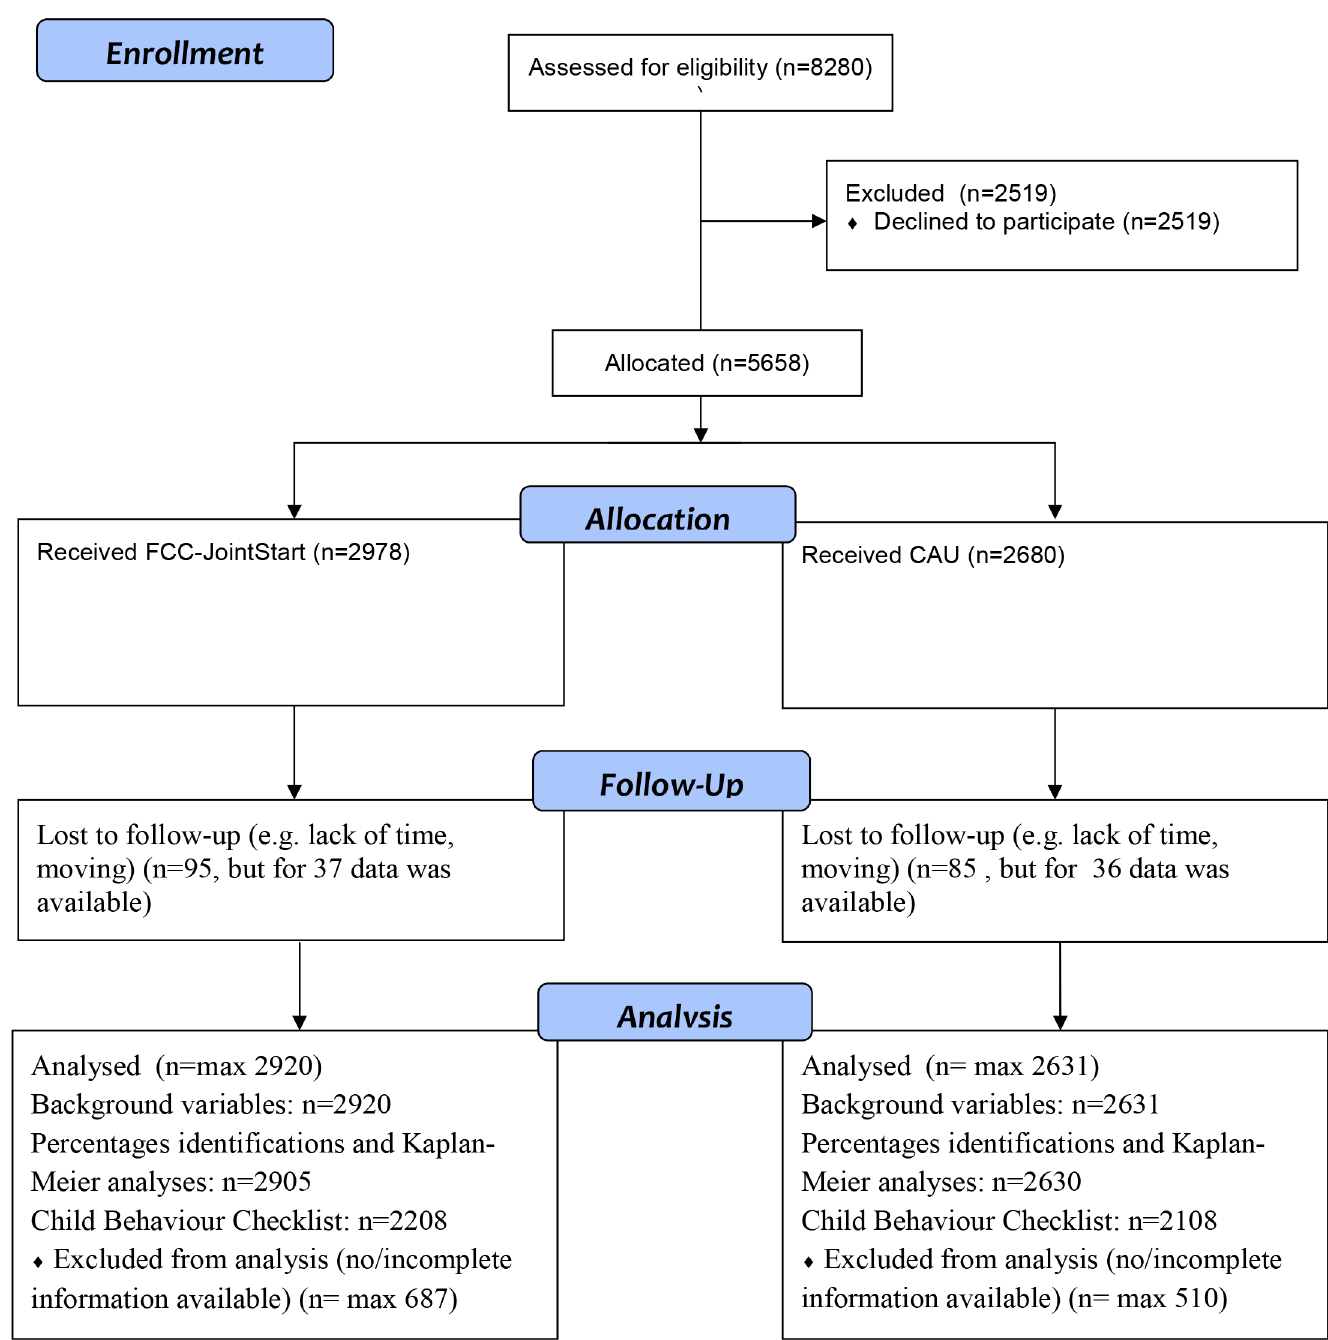
Fig 1. Flow of participants through the